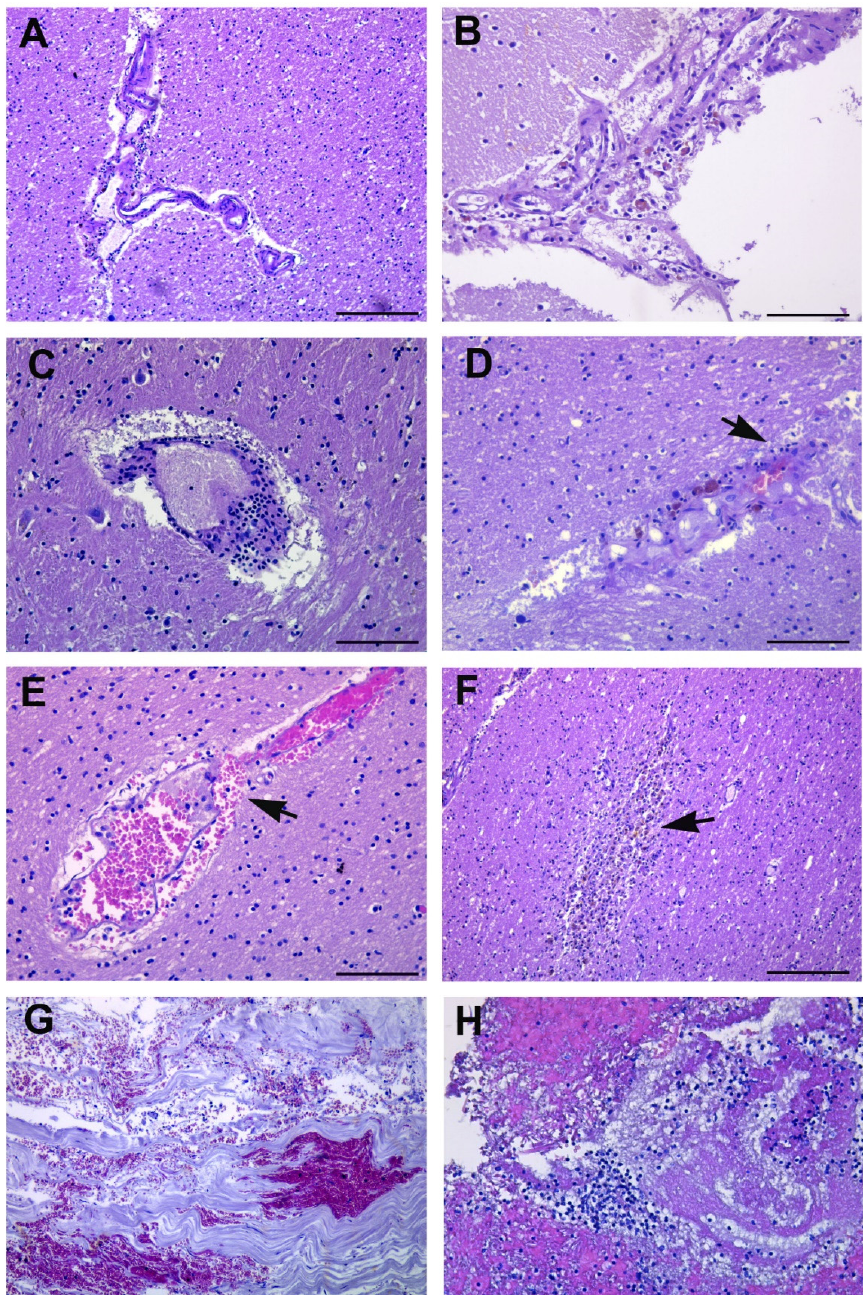
Figure 6. Brain histopathological findings. ( A ) Perivascular lymphocytic infiltrates the cortical parenchyma around the cerebral vessels. ( B ) Perivascular spread of inflammatory cells in the cerebellar cortex. ( C ) Basal nuclei. Perivascular cuffing by lymphocytes within the gray matter. ( D ) Cortical white matter section showing gliosis associated with a cluster of lymphocytes and macrophages around the blood vessel. Arrow points to siderophages. ( E ) Perivascular hemorrhage in the pontine region due to the rupture of the blood vessel wall (arrow) associated with the presence of inflammatory cells. ( F ) Necrotic cerebral cortex tissue (subacute-chronic cerebral infarction) (arrow) showing numerous infiltrating cells. ( G , H ) Meninges sections with hemorrhage and inflammation associated with necrosis. Images from patients who did not have previous neurological deficits. Scale bars: ( A , F , G ) = 100 μ m; ( B – E , H ) = 50 μ m. Immunohistochemical characterization of perivascular inflammatory cells in the cere- bral cortex and pons showed the presence of T lymphocytes, CD3 positive (Figure 7A), showing predominantly a CD8+ immunophenotype (Figure 7C), and less of a